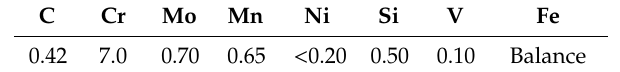
Table 1. Main chemical composition of the considered materials (mass, %).